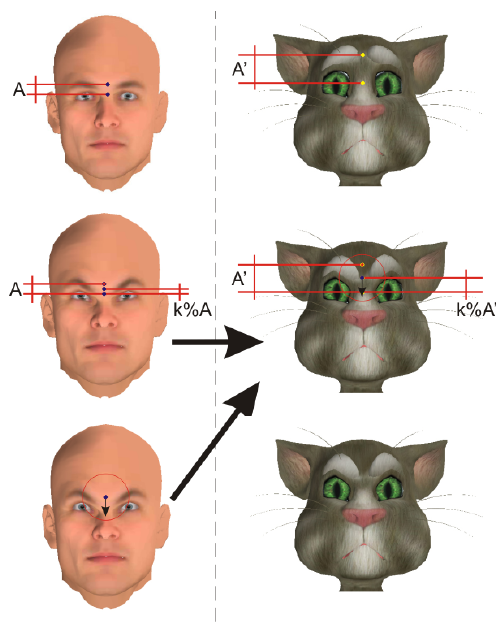
Figure 20. Example of proportion of the base model and the expression transferred to the new model.